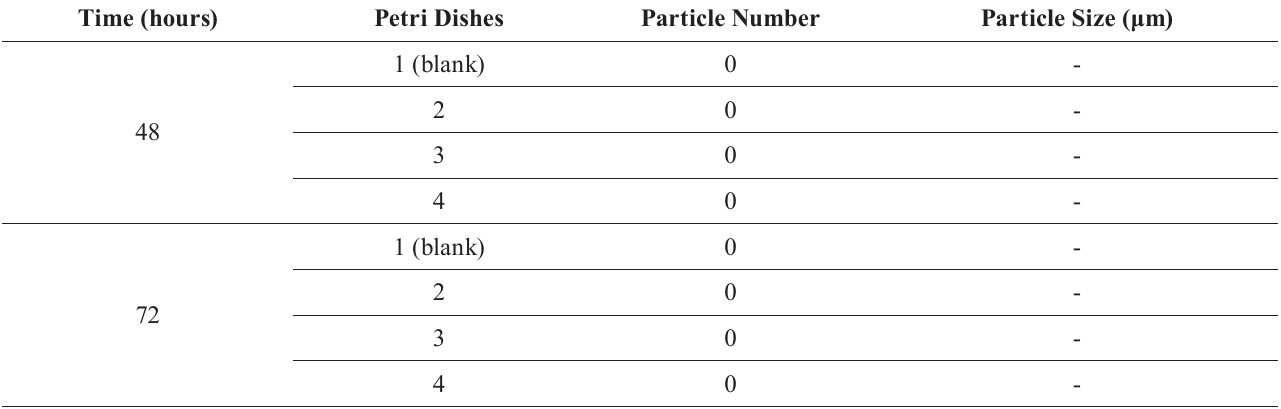
(*) Particle with amorphous appearance Source: Elaborated by the